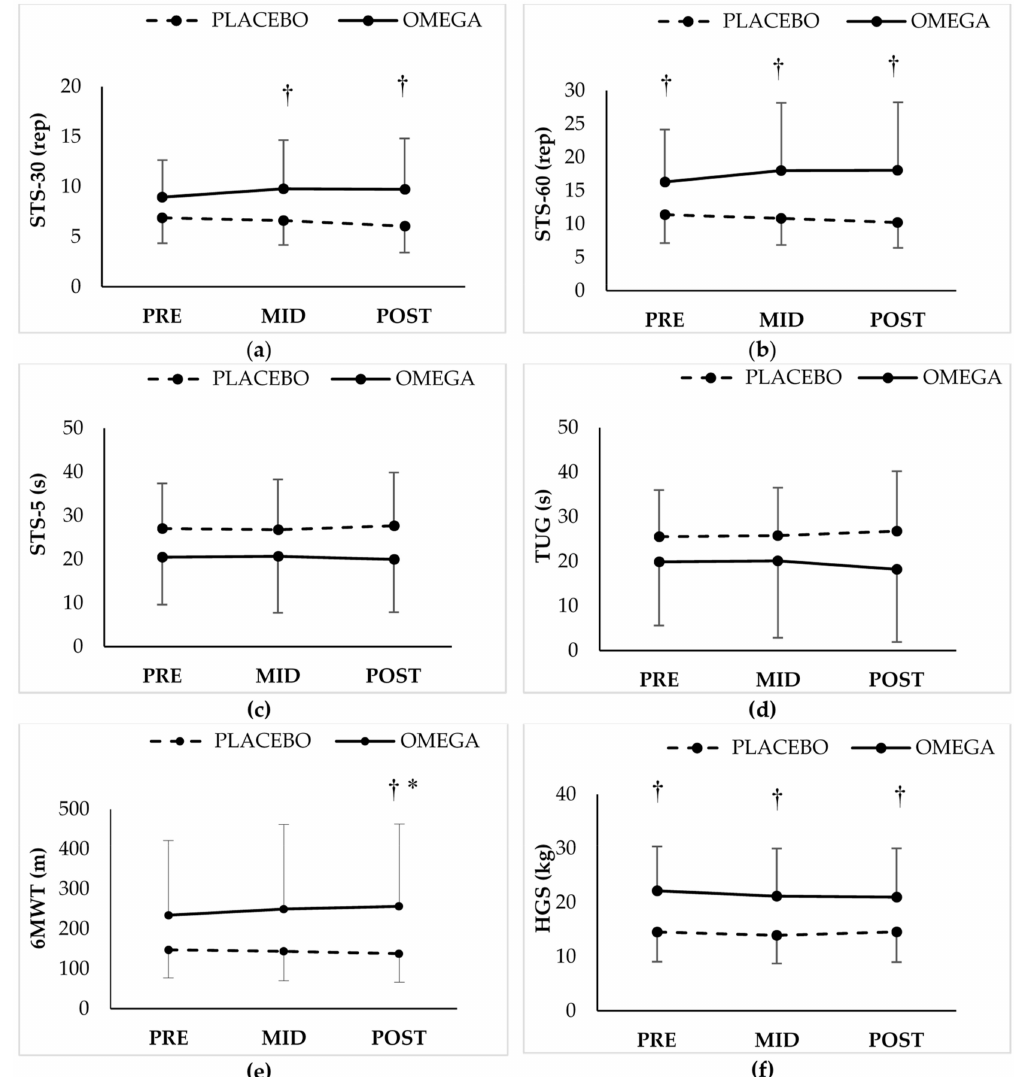
Figure 3. Functional tests (( a ) Sit-to-stand-30; ( b ) Sit-to-stand-60; ( c ) Sit-to-stand-5; ( d ) Timed-up-and-go; ( e ) 6-min walk test; ( f ) Handgrip strength) for each group at pre, mid (3mo) and post (6mo) of placebo or omega supplementation. † : p ≤ 0.05 from the corresponding value in placebo; *: p ≤ 0.05